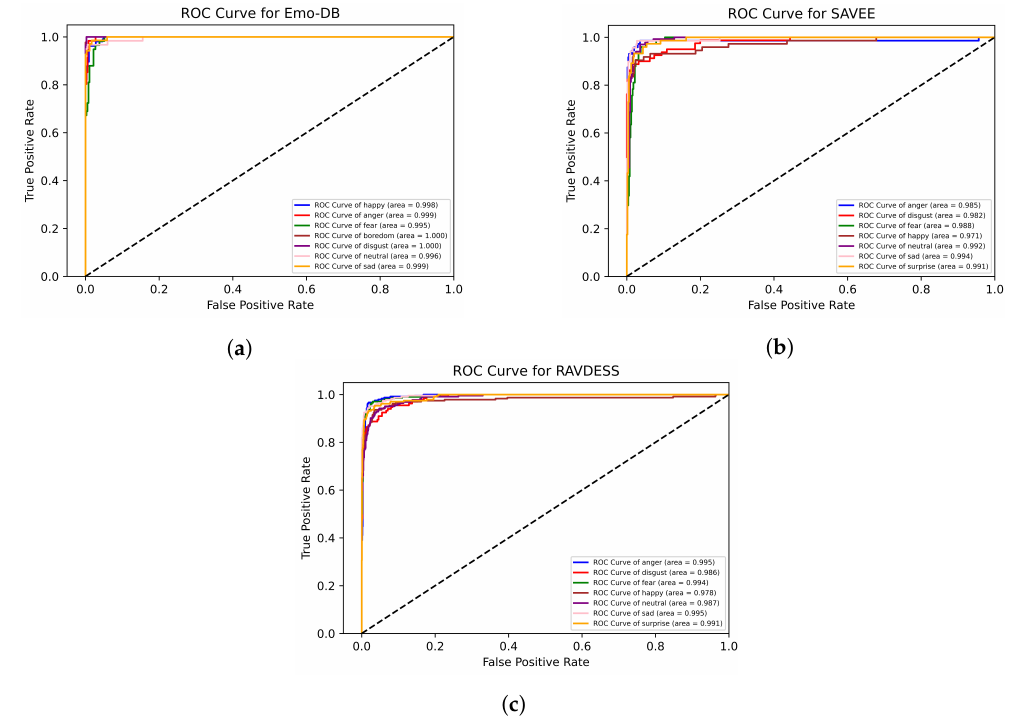
Figure 5. ROC Curves of the ( a ) EMO-DB, ( b ) SAVEE, and ( c ) RAVDEES